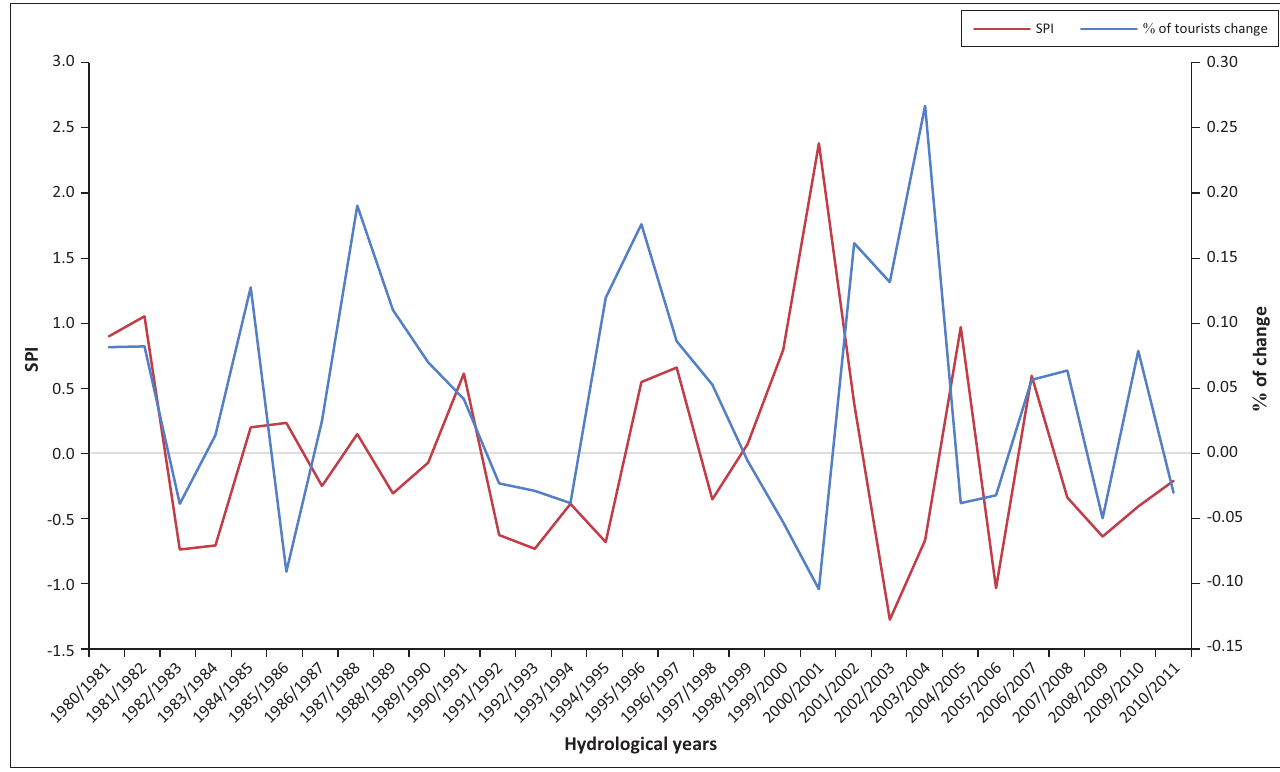
FIGURE 5: Correlation of percentage of tourist change to the Kruger National Park and the computed Standardised Precipitation